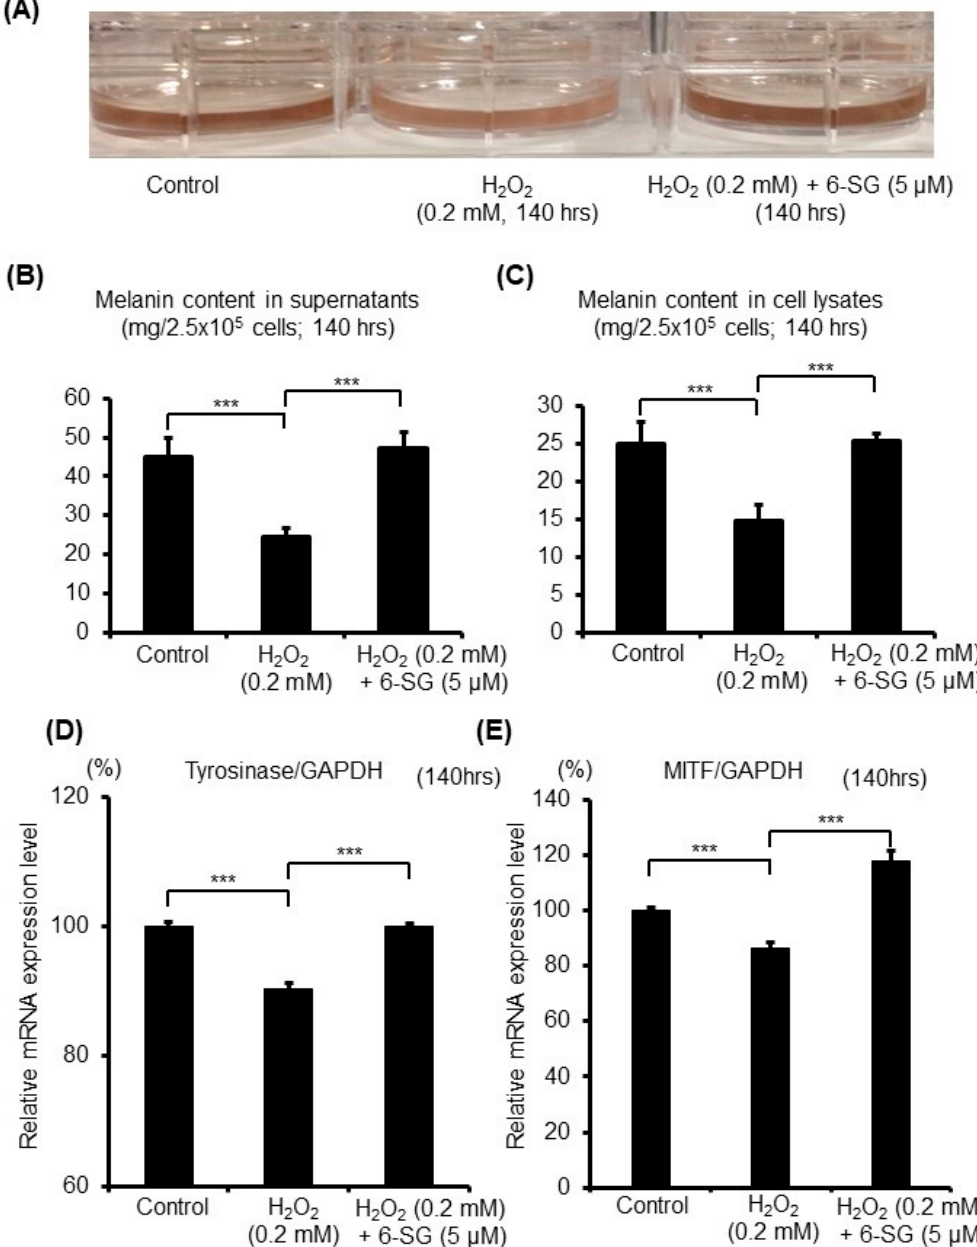
Figure 2. Melanin synthesis in cultured human epidermal melanocytes after 140 h exposure to the indicated treatments with 6-SG. ( A ) Photography of cultured cells with medium; ( B ) Melanin content quantification by melanin content assay in culture medium; ( C ) Melanin content quantification by melanin content assay in cell lysates; ( D ) Tyrosinase and ( E ) MITF) mRNA expression level evaluation by real-time PCR analyses with normalization to that of GAPDH. Data (B, C, D and E) represent the results of three independent experiments. Data are shown as mean ± SD. ***, p < 0.01. Tyrosinase is well known as the key enzyme in melanin biosynthesis, catalyzing the only rate- limiting steps in melanogenesis [26]. After pretreating HEMn-MPs for 6 h with 5 µM 6-SG, and after exposure to 0.2 mM H 2 O 2 for 140 h, the expression level of tyrosinase was evaluated by real-time PCR analysis (Figure 2D). The mRNA expression level of tyrosinase significantly decreased in the cells treated with 0.2 mM H 2 O 2 compared with control cells, and 6-SG pretreatment significantly blocked the H 2 O 2 -induced decrease in tyrosinase expression (Figure 2D). Microphthalmia-associated